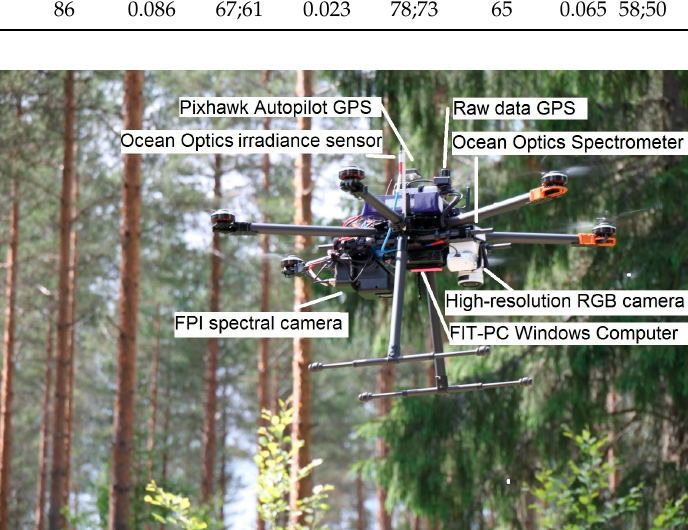
Figure 2. Unmanned aerial vehicle (UAV) remote sensing system of the Finnish Geospatial Research Institute (FGI) is based on the Tarot 960 hexacopter.